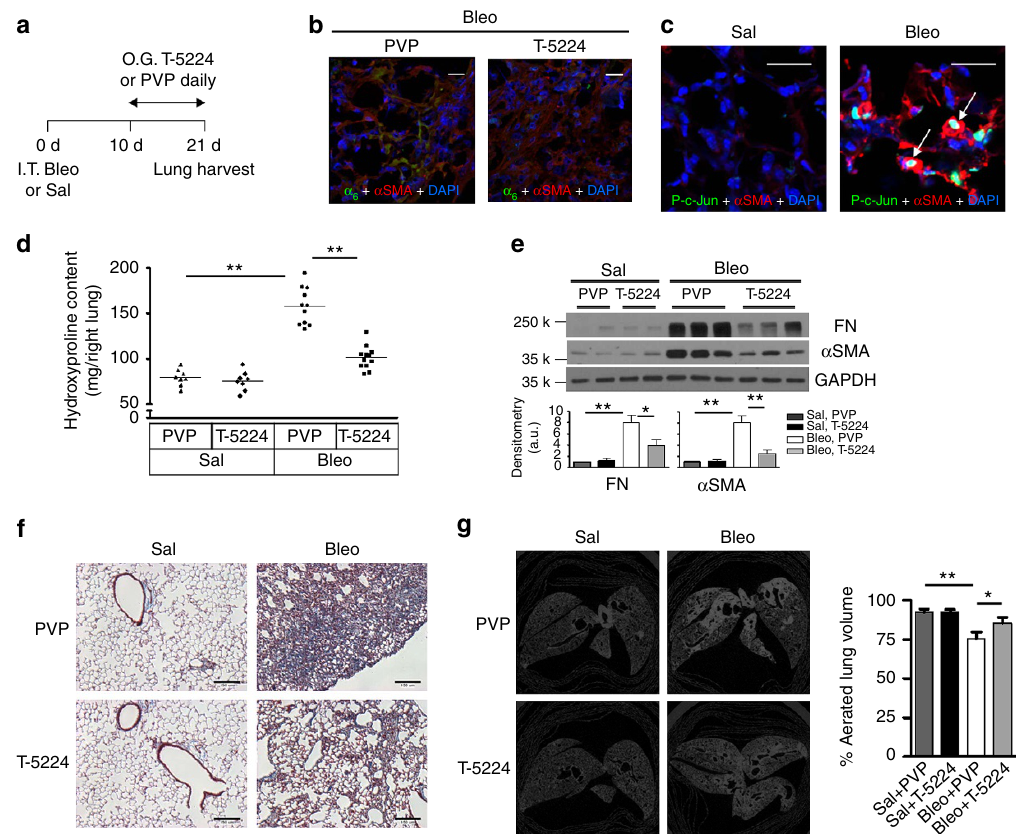
Figure 5 | Pharmacological inhibition of c-Fos/c-Jun protects mice against bleomycin injury-induced experimental lung fibrosis. ( a ) Animal experimental design. ( b ) Overlaid confocal immunofluorescent images show a 6 -expression (green) in a SMA-positive lung myofibroblasts (red) in mice with treatments as indicated. Nuclei were stained by DAPI (blue). Scale bar, 20 m m. ( c ) Overlaid confocal immunofluorescent images show phospho c-Jun (green) in the nuclei of a SMA-positive lung myofibroblasts (red) (arrows) in mice treated with saline or bleomycin. Nuclei were stained by DAPI (blue). Scale bar, 20 m m. ( d ) Quantification of hydroxyproline contents in right lungs of C57BL6 mice in four groups: Sal þ PVP, Sal þ T-5224, Bleo þ PVP and Bleo þ T-5224. Results are the means ± s.d. ( e ) Quantification of FN and a SMA protein expression in left lungs by immunoblot. Shown are representative blots. ( f ) Representative images for trichrome staining of collagens in paraffin-embedded lung tissue sections. Scale bar, 150 m m. ( g ) Shown are representative images for ex vivo mid-lung transaxial m CT scans. The average percentages of aerated lung volumes are shown in the bar graph ( n ¼ 5 mice per group). Results are the means ± s.d.; * P o 0.05 and ** P o 0.01; one-way analysis of variance. O.G., oral gavage.